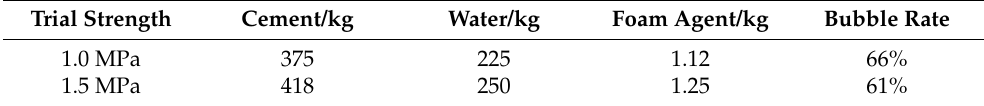
Table 1. Mix proportion of foam concrete. Trial Strength Cement/kg